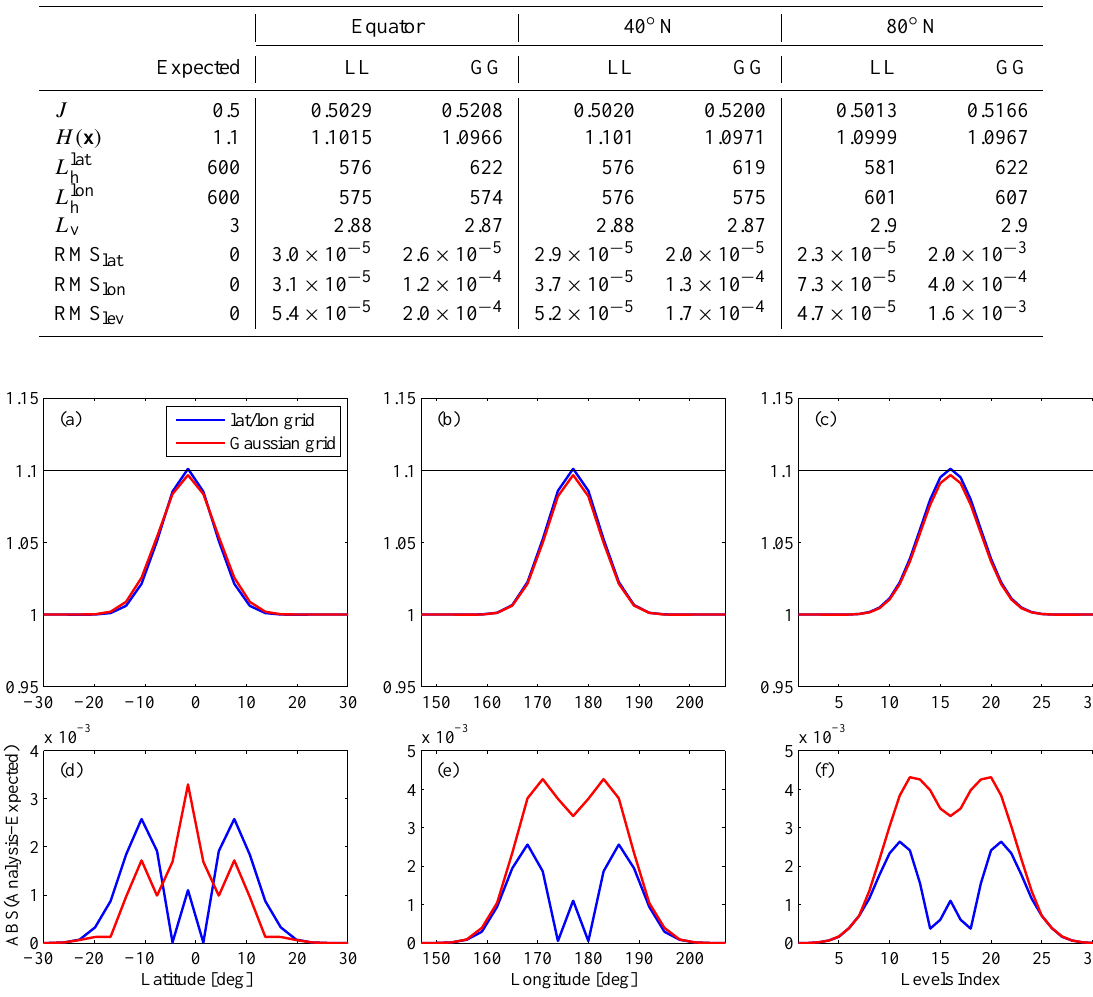
Fig. 1. Cross-sections of the analyses obtained by the assimilation of a single pseudo-observations located at the Equator using Gaussian spatial correlation function and two target grids of the spectral transform: the lat/lon grid (blue line) and the Gaussian grid (red line). The correlation length scales are L h = 600km horizontally and L v = 3 model levels vertically. The three top panels show the cross-section of theses analyses along the latitude (a) , the longitude (b) and the altitude (c) , all crossing the observation location. The horizontal black lines at value 1.1 indicate the theoretical analyses at the observation location. The bottom panels display the differences between the analysed cross-sections and the expected